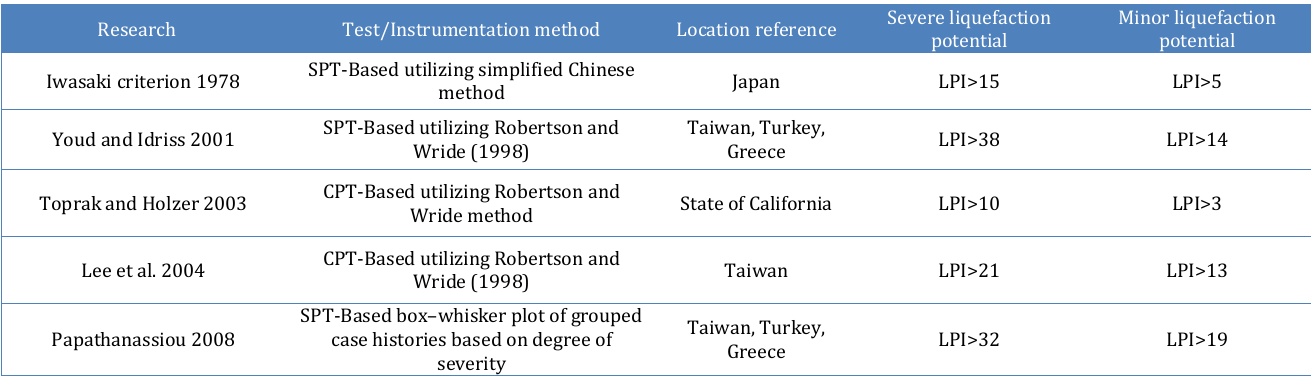
Table 1: Liquefaction potential indices (LPI) developed after SPT and CPT